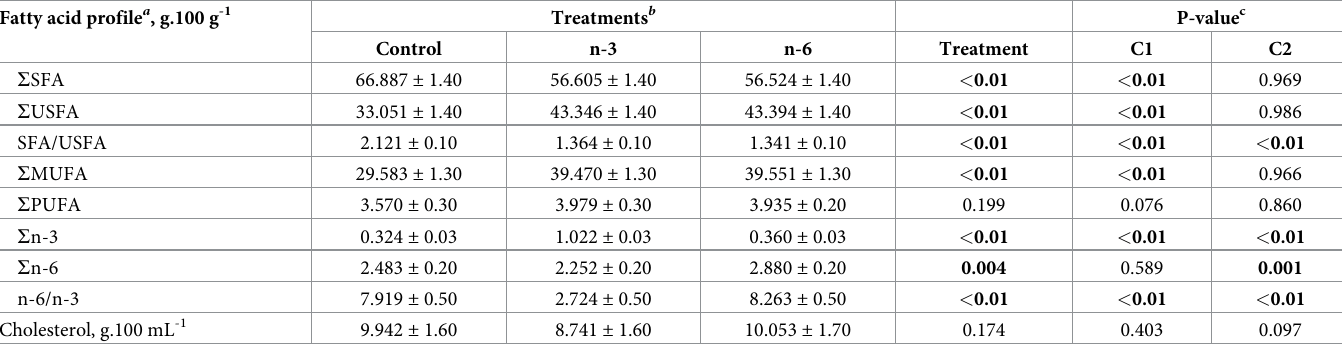
Table 2. The lipid fraction of enriched cow’s milk. Fatty acid profile a , g.100 g